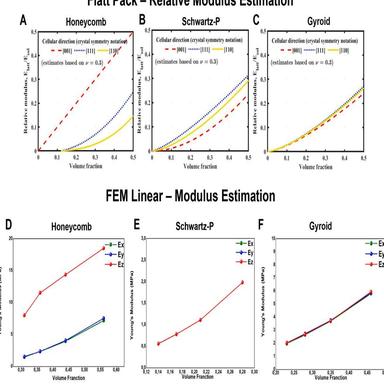
Comparison of (A-C) FLatt Pack – Relative Modulus Estimation and (D-F) linear FE models to explore the elastic modulus against volume fraction for selected cell type along the x, y, and z directions. In (E) all curves perfectly overlap.